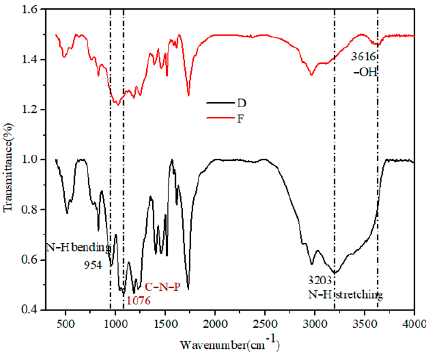
Figure 5. Infrared spectra of HPN-EPPA-UR-PA resin, D: 10 wt% urea; F: 0.